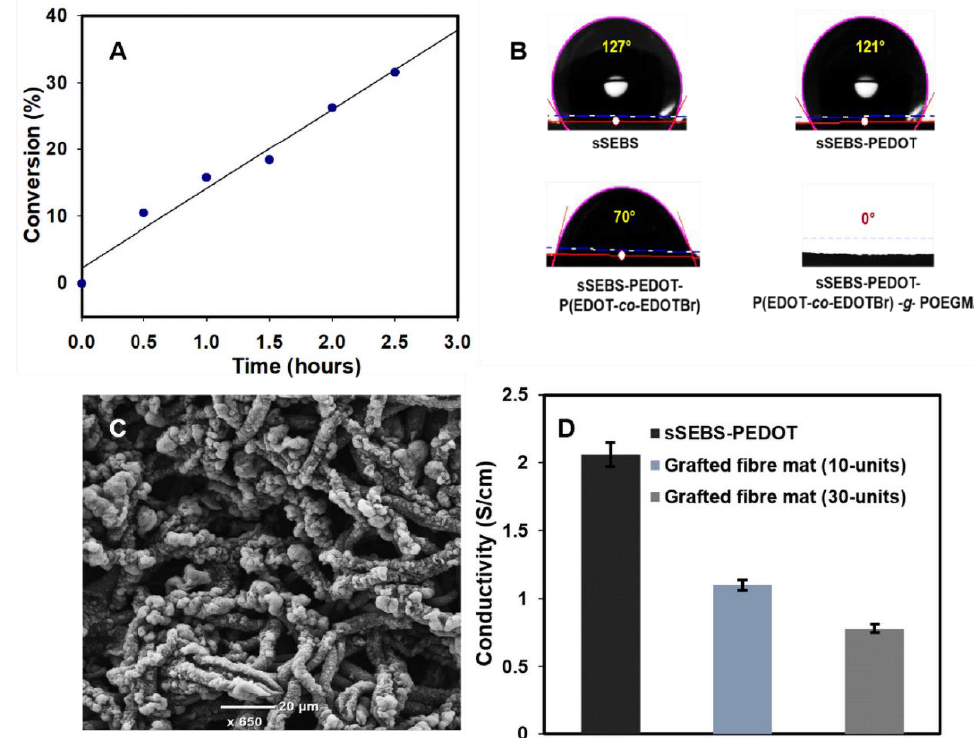
Figure 3. ( A ) SI-ATRP kinetics graph for POEGMA grafting on electrospun fibre mats, ( B ) Contact angle measurement of sSEBS, sSEBS-PEDOT, sSEBS-PEDOT/P(EDOT -co- EDOTBr) and sSEBS-PE- DOT/P(EDOT -co- EDOTBr) -g- POEGMA (30-mers) fibre mat, ( C ) SEM image of sSEBS-PE- DOT/P(EDOT -co- EDOTBr) -g- POEGMA (30-mers) fibre mat, and ( D ) Conductivity of the sSEBS-PE- DOT and sSEBS-PEDOT/P(EDOT -co- EDOTBr) -g- POEGMA fibre mat with 10- and 30-mers graft length ( n =